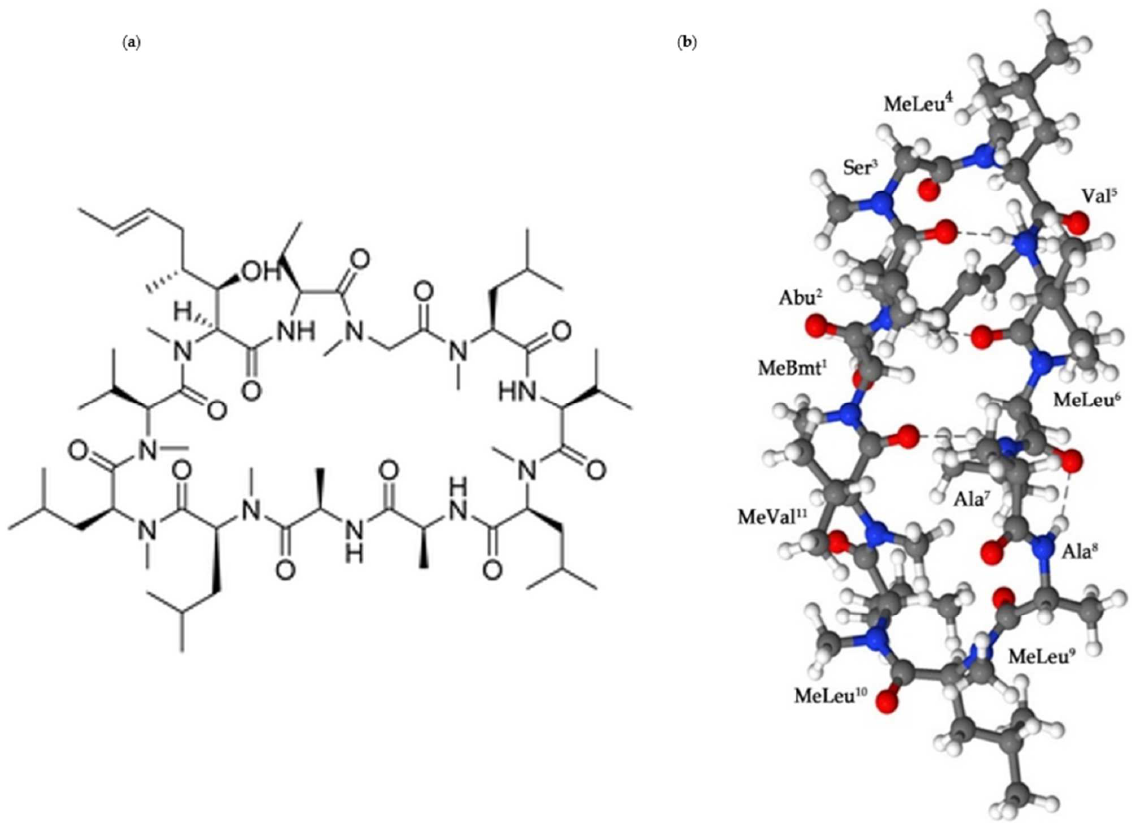
Figure 1. ( a ) The chemical structure of Cyclosporine A (C 62 H 111 N 11 O 12 ); ( b ) The crystal structure of CsA. Blue—nitrogen; red—oxygen; gray—carbon; proton atoms—white [20,21].